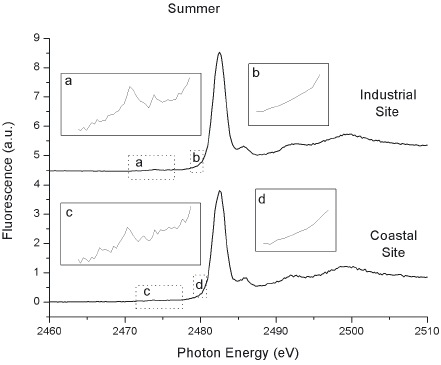
Figure 3. Sulphur K-edge XANES spectra for the PM10 samples of the two sites collected during the summer season (zoomed areas a and c: detail between 2470 eV and 2478 eV; zoomed areas b and d: detail between 2478 eV and 2480 eV).